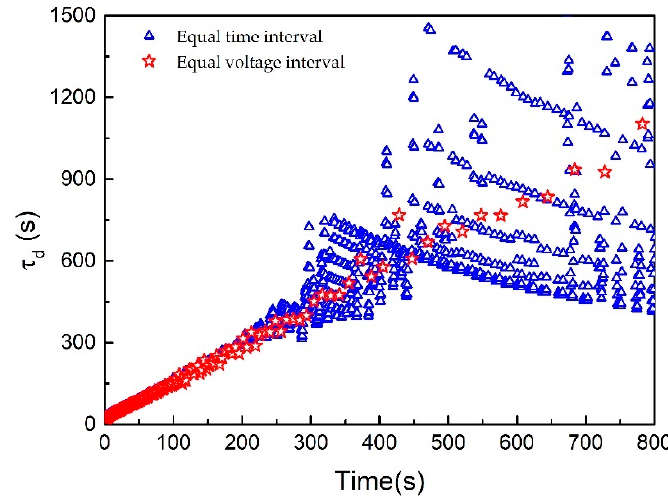
Figure 4. Comparison between equal time interval and equal voltage interval method.